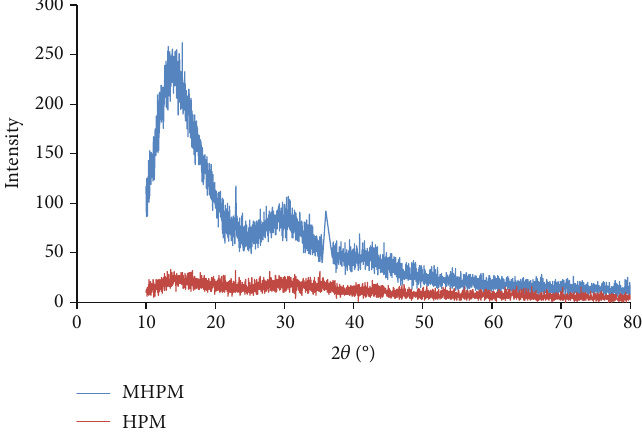
Figure 4: X-ray di ff raction (XRD) patterns of HPM (red) and MHPM (blue).